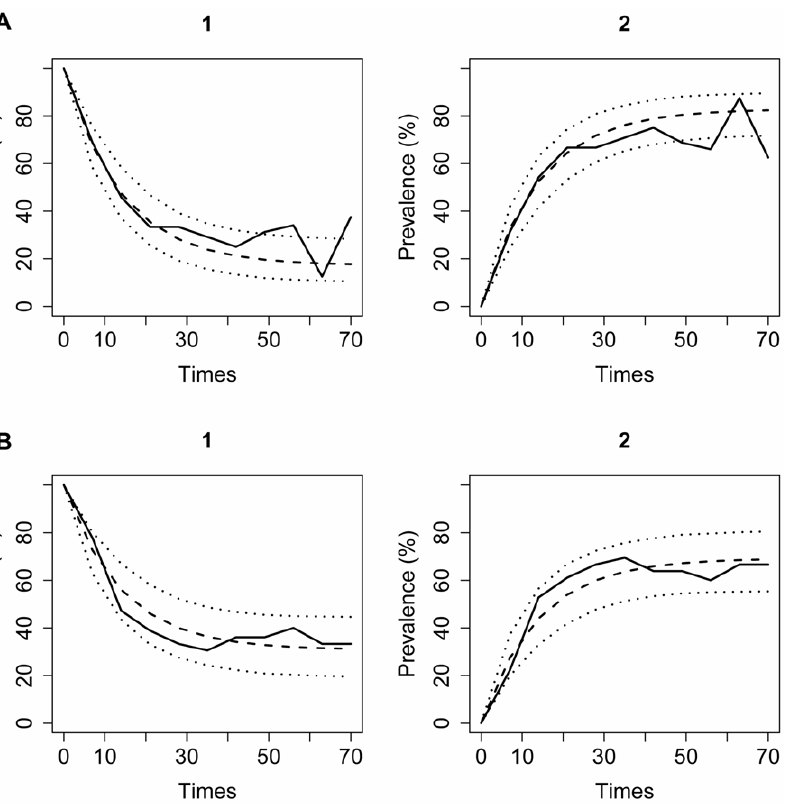
Figure 4. Observed versus expected prevalence of pigs in the states of the immune response model. Shown are prevalences for the models using the custom cut-offs (panel A) and manufacturer based cut-offs (for all serotypes except S. Yoruba; panel B). The states are labeled 1 and 2, denoting an immune response below and above the seroconversion level, respectively. Full line indicates the observed, while dashed and dotted lines denote mean and 95% CI of the expected